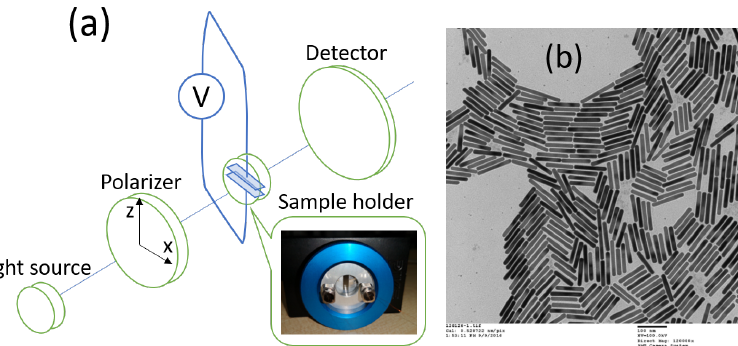
Figure 3. ( a ) Schematic representation of the experimental setup. ( b ) Electron microscope image of gold nanorods (provided by Nanopartz Inc., Loveland, CO, USA).